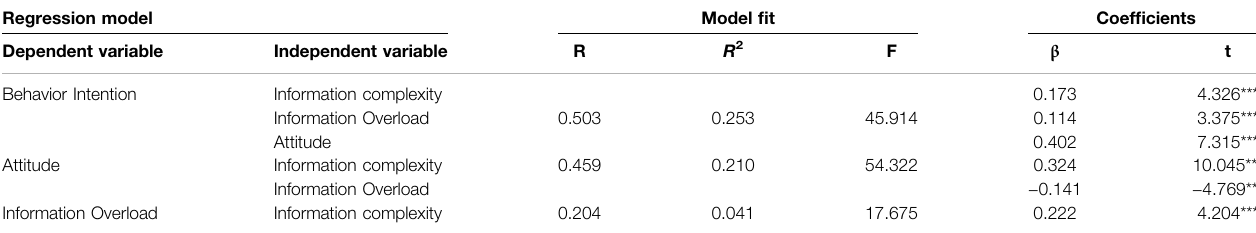
TABLE 2 | Multiple regression analysis of information overload and attitude between information complexity and behavior intention. Regression